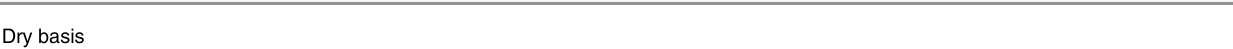
Table 1. Chemical characterization of substrates used in the digestion experiments. Material TS (%) VS (%) Organic carbon a (g/kg